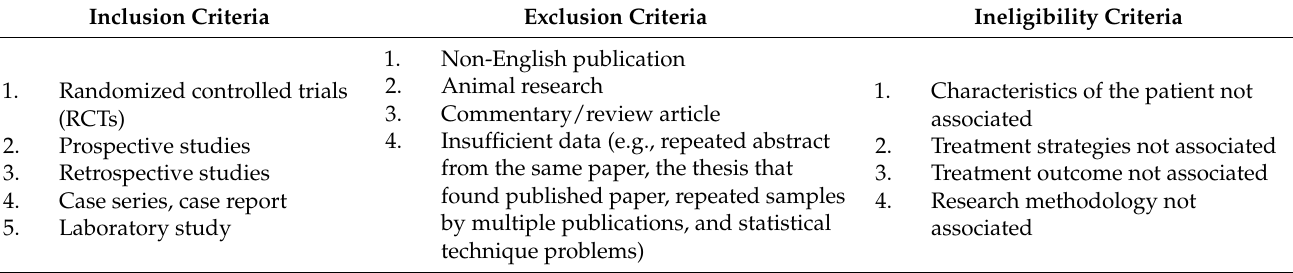
Table 2. Selection criteria of the